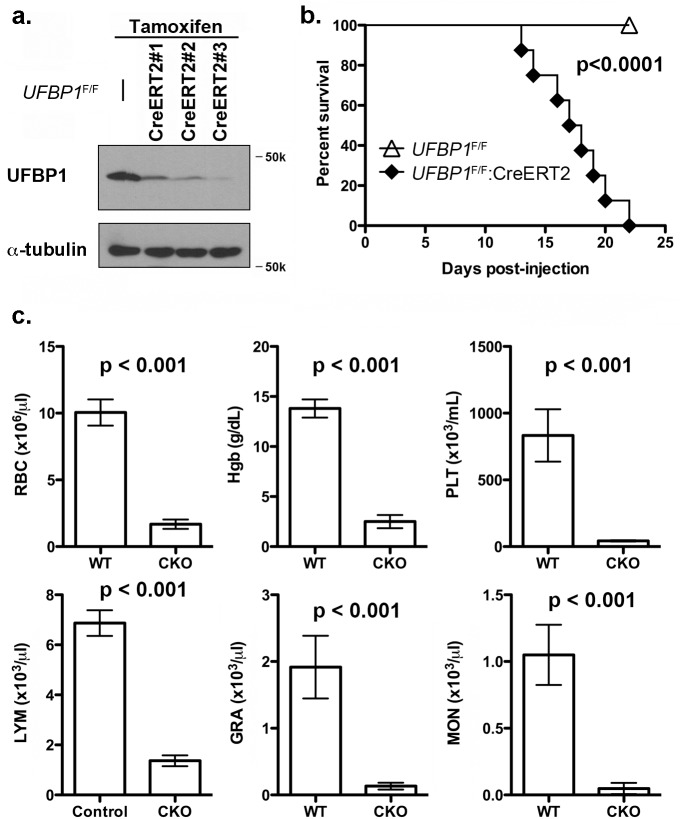
Loss of UFBP1 in adult mice results in severe pancytopenia and animal death.
a. Confirmation of UFBP1 depletion in bone marrow cells of TAM-injected CKO mice. Floxed mice were IP injected with tamoxifen according to a standard protocol. BM cells were collected and subject to immunoblotting of UFBP1. b. Survival curve of UFBP1 deficient mice after TAM injection, p < 0.001 (n = 12 each group). c. The result of CBC counts. Data are presented as means ± SD. The blood was drawn from control (UFBP1
F/F) (n = 5) and UFBP1 deficient mice (UFBP1
F/F:CreERT2) (n = 5) when UFBP1 deficient mice became moribund and/or lost 20% of body weight after TAM injection (between 2–3 weeks post-TAM treatment). Blood samples were subjected to CBC analysis. The mice used in this experiment were ~ 8-week old male mice. RBC: red blood cell; Hgb: hemoglobin; PLT: platelet; LYM: lymphocyte; GRA: granulocyte; MON: monocyte.